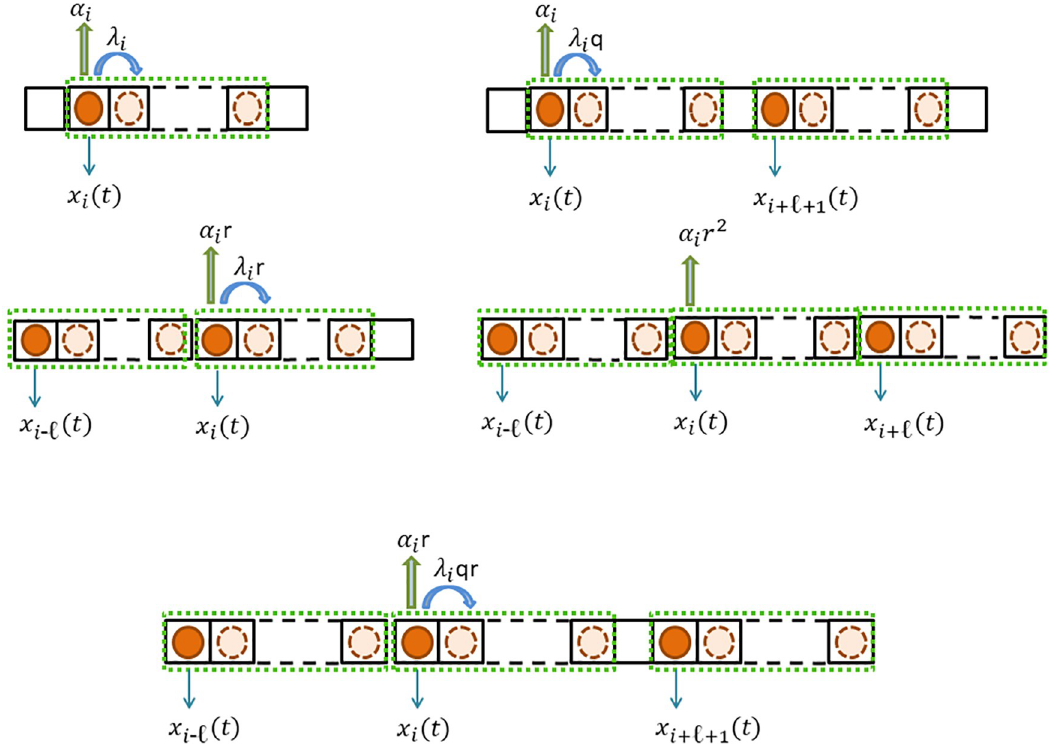
Fig 2. The particle covers ℓ sites and the dark red label denotes the reader location. Schematic explanation of the transition flow from site i to site i + 1 in the EFEIOD: Upper-left: When there are no readers at sites i − ℓ , i + ℓ and i + ℓ + 1, the transition rate is λ i and detachment rate is α . Upper-right: When there is a reader at site i + ℓ + 1 and site i − ℓ does not have, the transition rate is λ i i q and detachment rate is α . Middle-left: When there is reader at site i − ℓ and no readers at sites i + ℓ and i + ℓ + 1, the transition rate is i λ i r and detachment rate is α i r . Middle-right: When there are readers at sites i − ℓ and i + ℓ , detachment rate is α i r 2 . Lower part: When there are readers at sites i − ℓ and i + ℓ + 1, the transition rate is λ and detachment rate is α . i qr i r